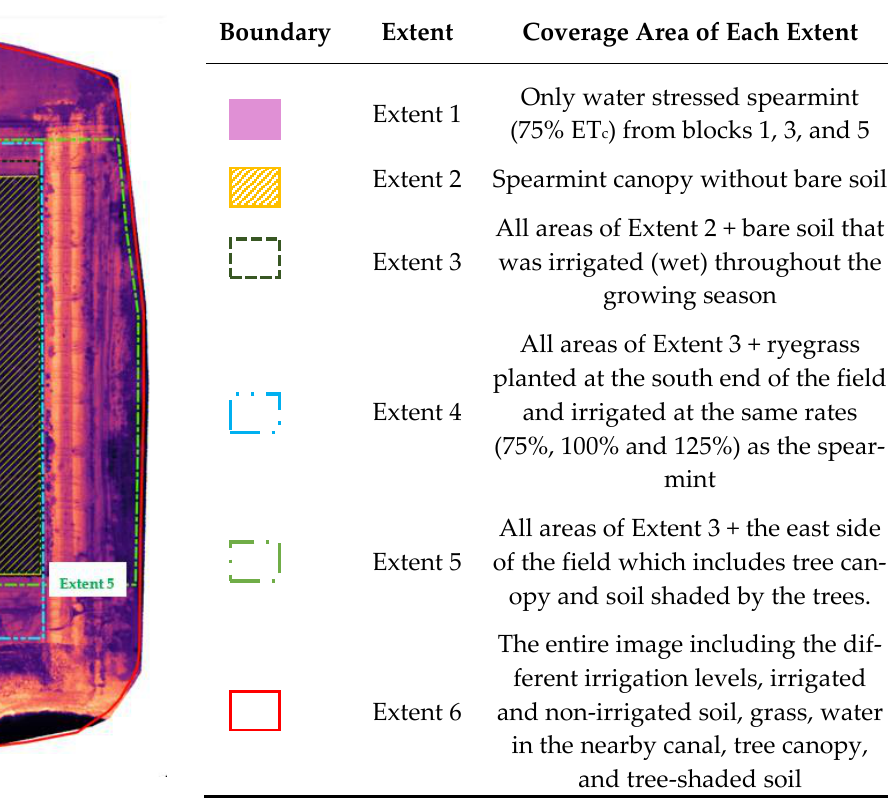
Figure 2. Different extents (cropped areas) of the UAS imagery used by UAS-METRIC to generate ET c maps.